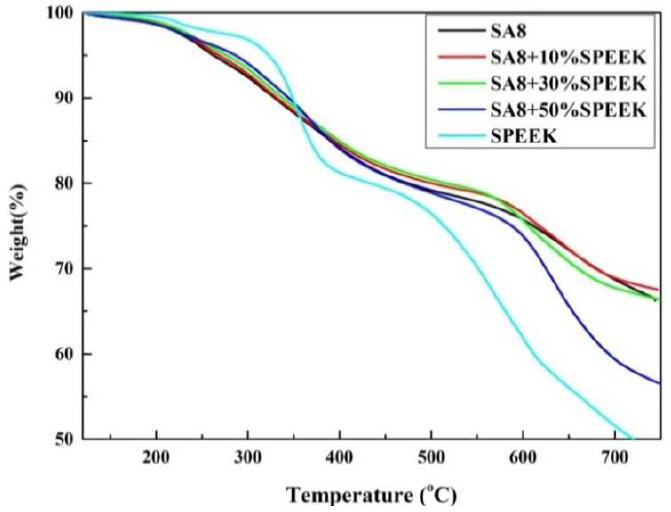
Figure 13. TGA diagram of SA8 polymer blended with sPEEK.